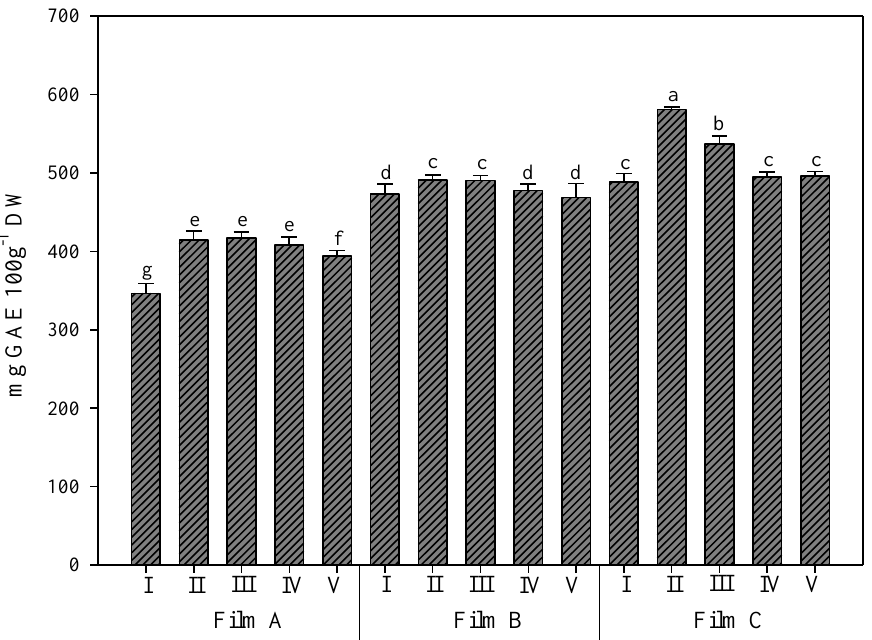
9 of 16 Figure 4. Carotenoid content (mg/100 g of dry weight D.W.) in wild rocket leaves as affected by interaction between greenhouse cover film (Film A: diffused light film; Film B: clear film; Film C: diffused light film with UV-B window) and UV-B applications (I: not treated with UV-B; II: treated with UV-B for 45 s; III: treated with UV-B for 150 s; IV: treated with UV-B for 330 s; V: treated with UV-B for 660 s). Vertical bars indicate standard error; different letters indicate significant differences